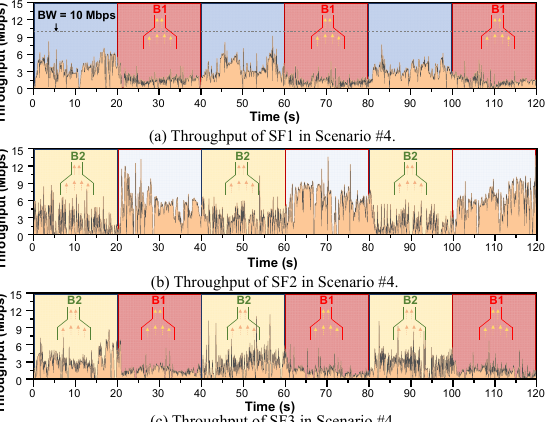
(c) Throughput of SF3 in Scenario #4. Figure 9. Throughput of the three MPTCP SFs in a randomly selected experiment in Scenario #4; ( a – c ) throughput for SF1–3, respectively.